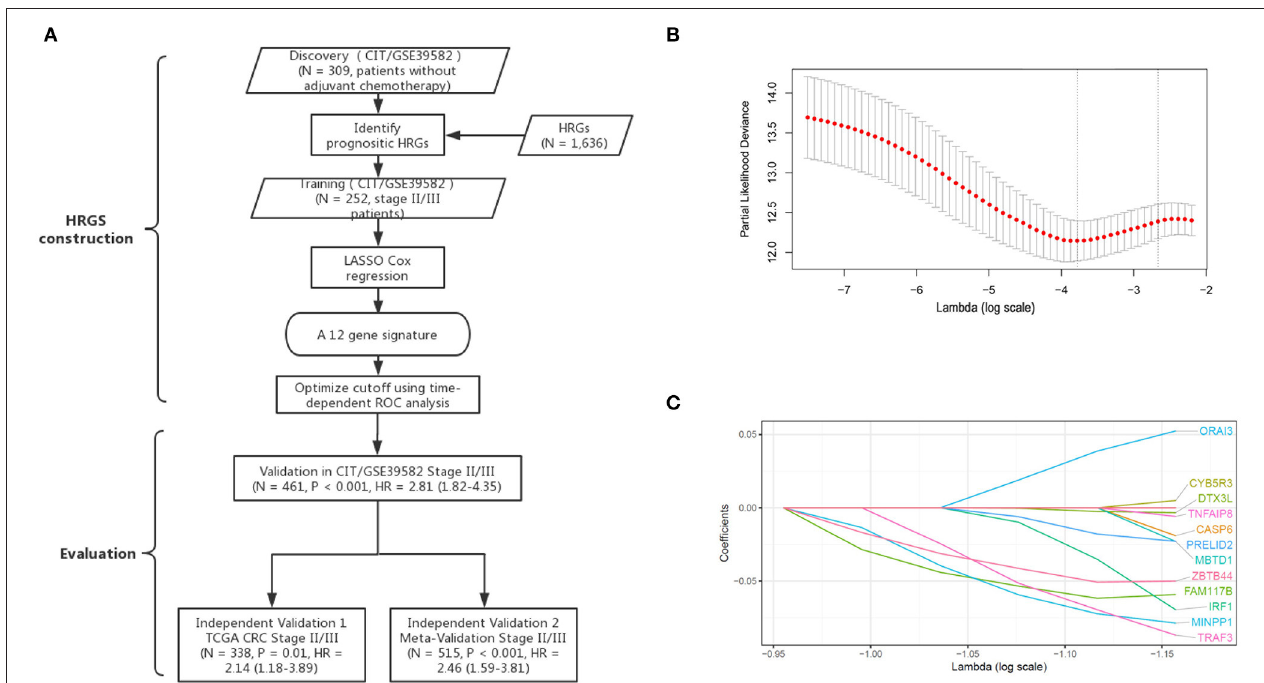
FIGURE 1 | Establishment and verification of HRGS. A schematic flowchart of study design and analysis steps (A) . The optimal lambda in the LASSO model was chosen, and the lowest standard 5-fold crossvalidation was used. By using the minimum standard and the minimum standard of 1 SE (1 – SE standard), a vertical line was drawn at the optimal value (B) . Twelve hypoxia-related genes selected in LASSO COX regression (C) .